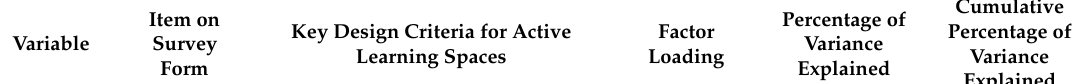
Table 4. Results of factor analysis on the 15 variables of key design criteria for active learning spaces.